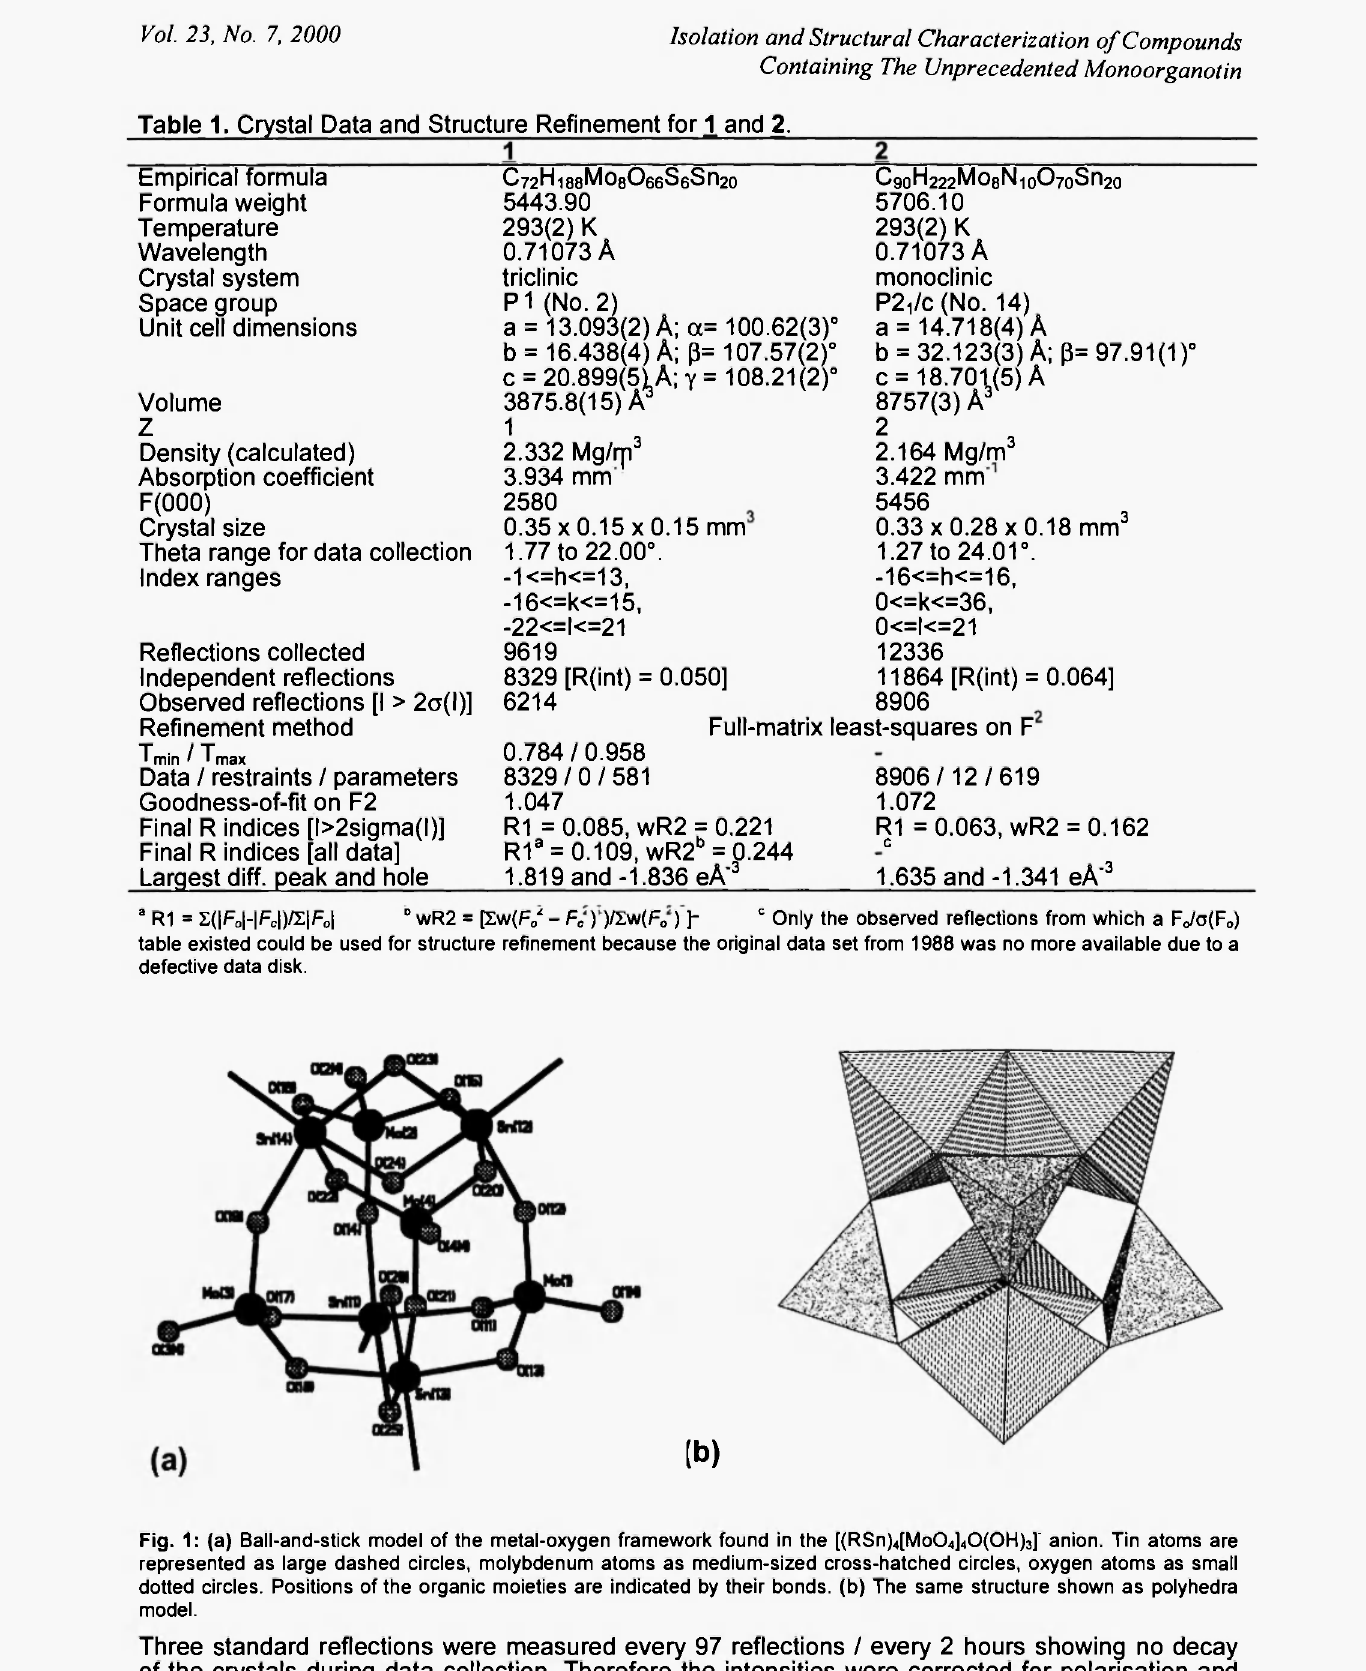
Table 1. Crystal Data and Structure Refinement f o ri and 2.